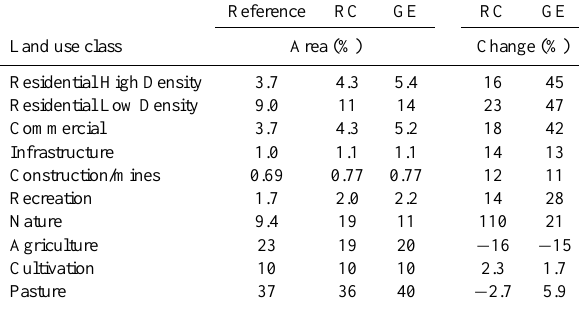
Table 3. Surface percentages of different land use classes in the flood prone area of the Rhine basin, for the reference situation in 2000, and the RC and GE scenarios in 2030. Percentages and Euros in Tables 3 through 7 are rounded to two significant